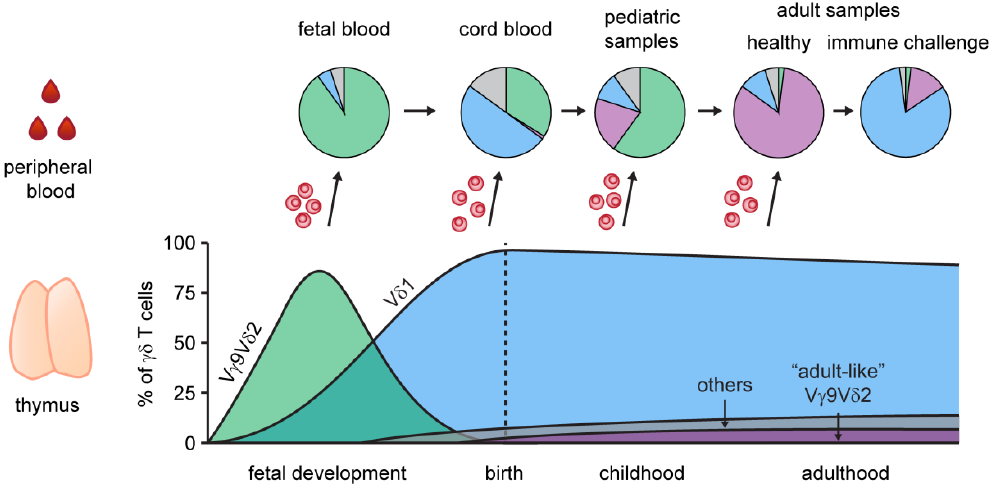
Figure 1. Developmental waves of human γδ T cells. The γδ T cell population in the human thymus shows characteristic waves of γδ T cell subpopulations, with distinct V-gene usage (lower panel). Schematic proportions of V γ 9V δ 2 + (fetal: green, adult-like: purple), V δ 1 (blue) and γδ T cells using other V-genes (“others”: gray) are shown as a percentage of all thymic γδ T cells. Migration of thymic γδ T cells and extrathymic changes subsequently contribute to the formation of the adult peripheral blood γδ T cell compartment (upper panel). The composition of peripheral blood γδ T cells from second trimester fetal blood to adults is illustrated by pie charts. Typical clonal expansions of V δ 1 + T cells were observed in a multitude of immune challenges (e.g., CMV), and indicate an adaptive-like γδ T cell response.